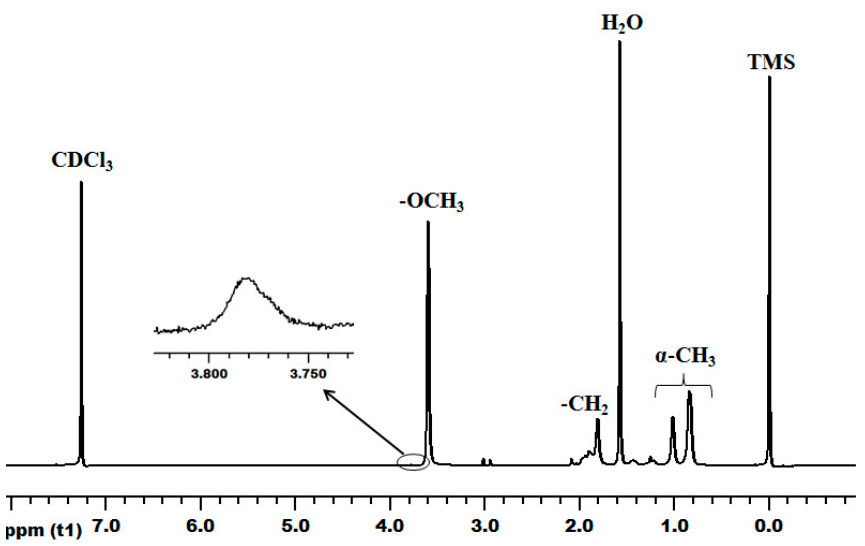
Figure 3. 1 H-nuclear magnetic resonance spectroscopy ( 1 H NMR) spectrum of PMMA formed in solution.